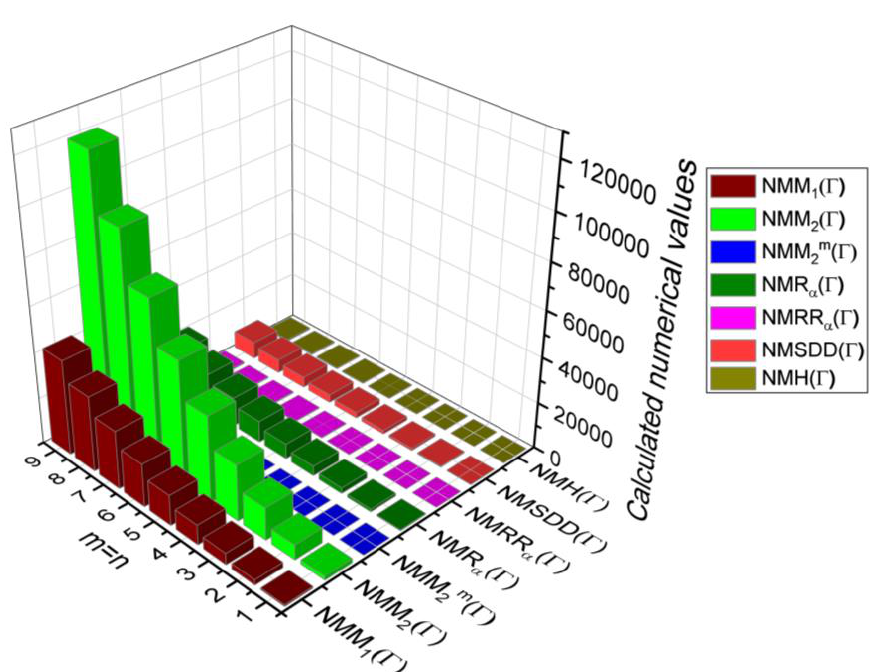
Figure 9. 3D plots for Table 8.